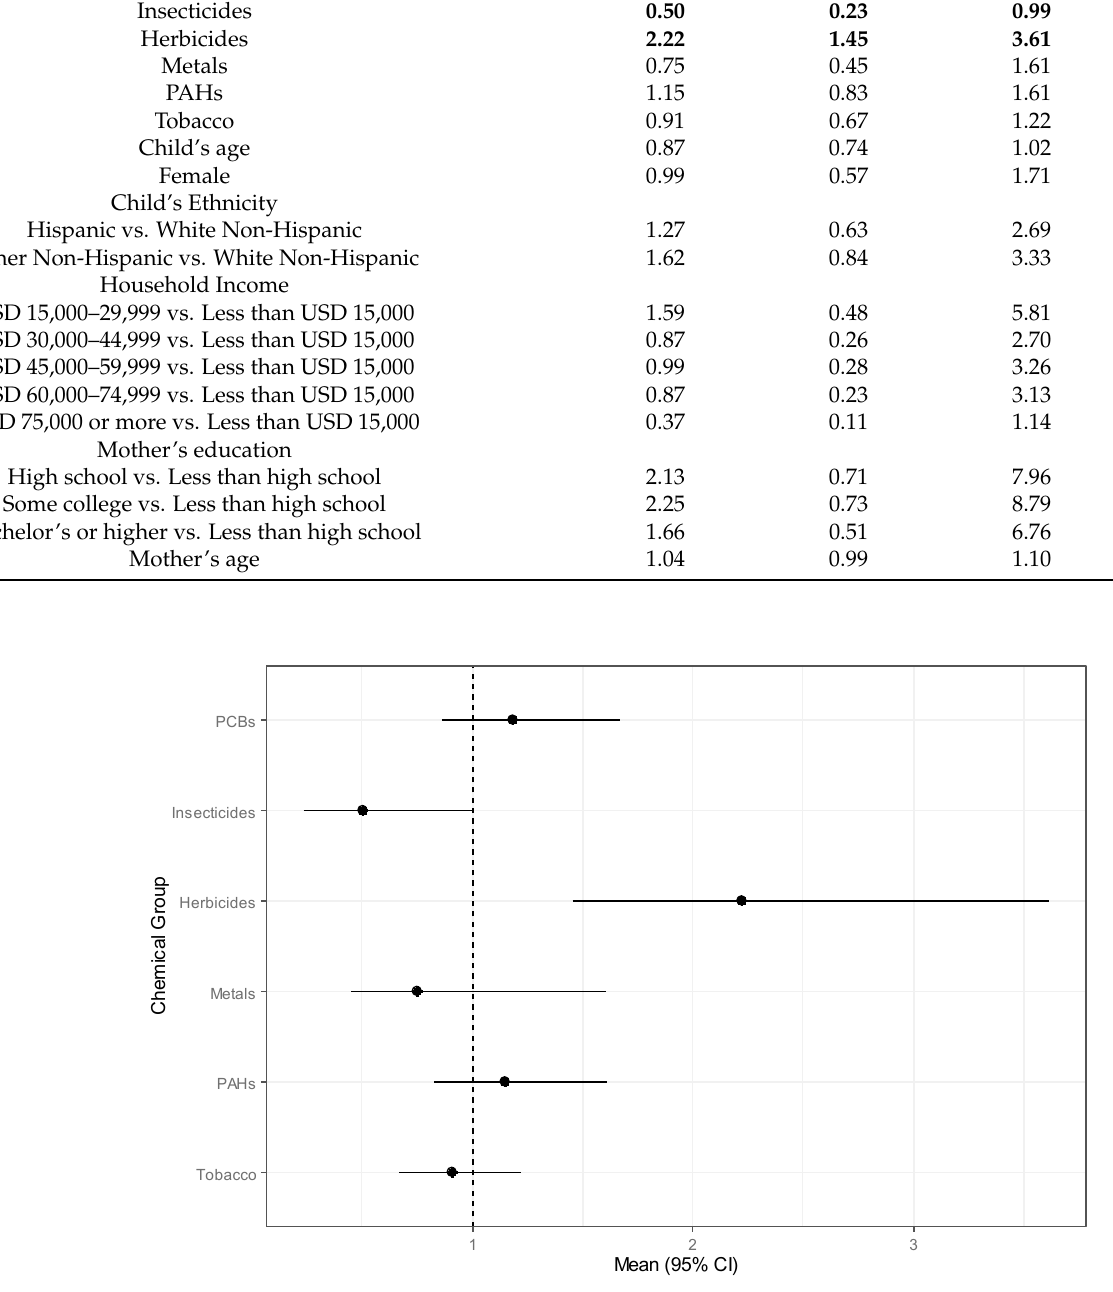
Figure 3. Forest plot of odds ratios and 95% credible intervals for chemical groups for childhood leukemia in children who lived at the same residence since birth with a line at the null value of 1.0.